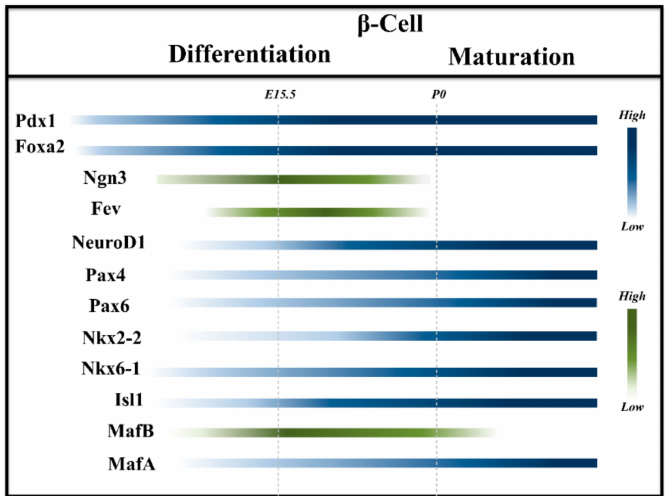
Figure 1. Pivotal TFs regulating β -cell di ff erentiation and maturation in rodents. Schematic representation of the most prominent TFs involved in endocrine induction, lineage specification, di ff erentiation and maturation of β -cells. Gradient colors represent the expression levels during the process. Green colored lines indicate the TFs that are transiently expressed, while the blue ones are those that remain expressed also in